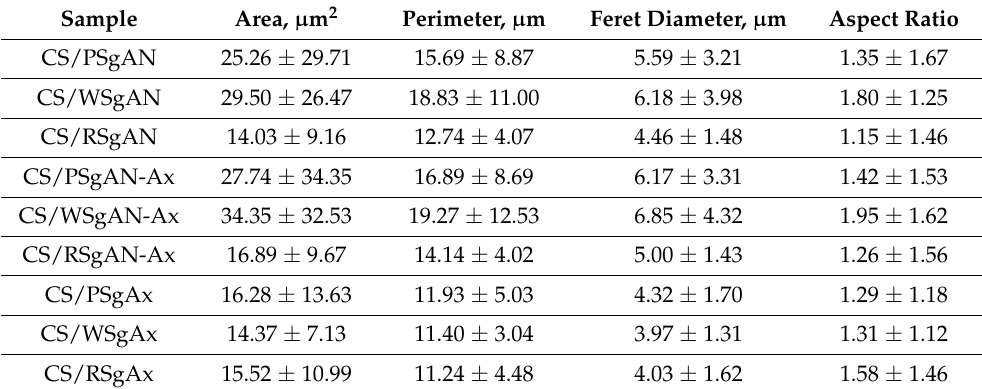
Table 1. Pore size analysis as area, perimeter, Feret diameter and aspect ratio (mean values ± standard